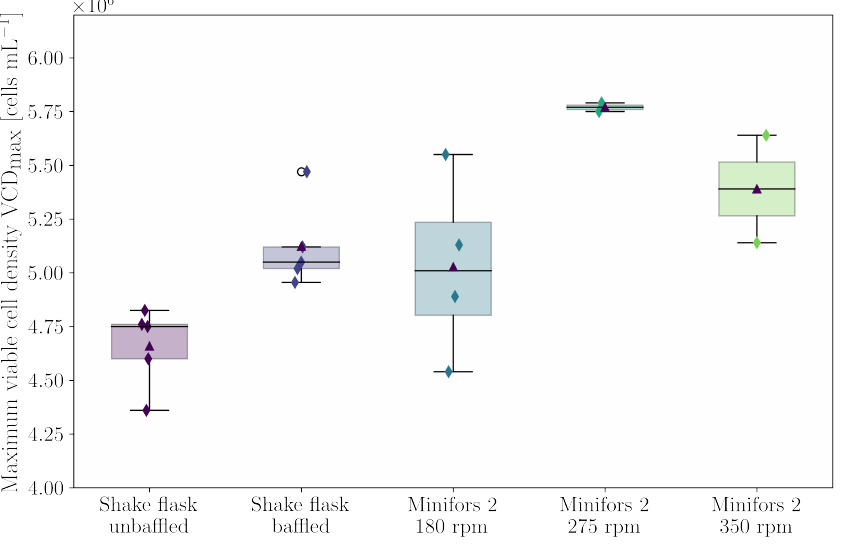
Figure 10. Box plot of the maximum VCD achieved in different cultivation systems and under different process conditions with viability at time VCD max above